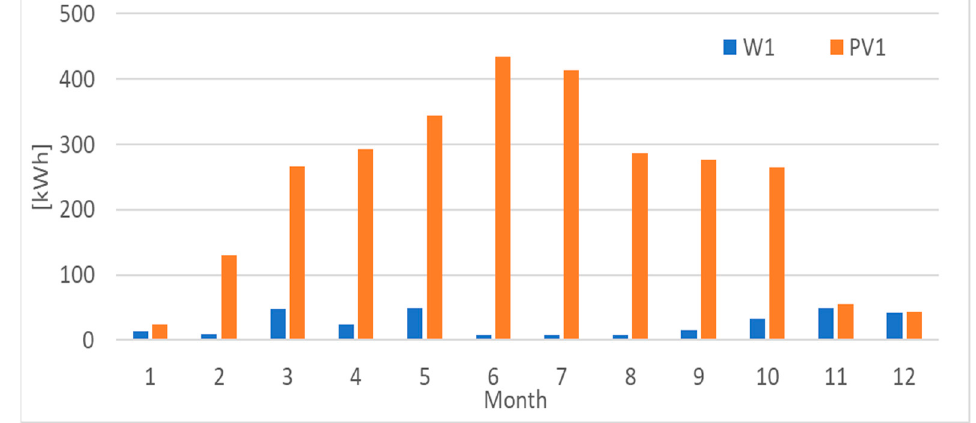
Figure 19. Share of PV1 and PV2a+PV2b sections in monthly generation of PV1 and PV2a+PV2b sections in 2021 (own measurement data).